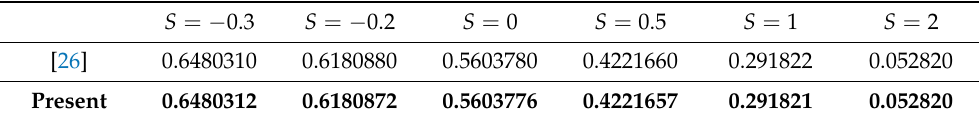
Table 6. Numerical values of θ (cid:48) ( 0 ) with disk fluctuation, keeping K vs = 0, λ = 0, Ω = 2,Pr = 1, α = 0.5, K s = 0, K c = 0, φ 1 = 0, φ 2 =